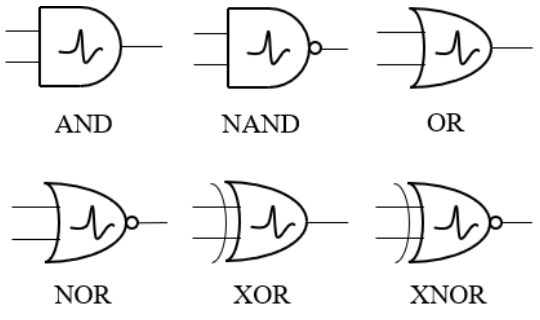
Figure 8. The icons of the basic SNN logical operation